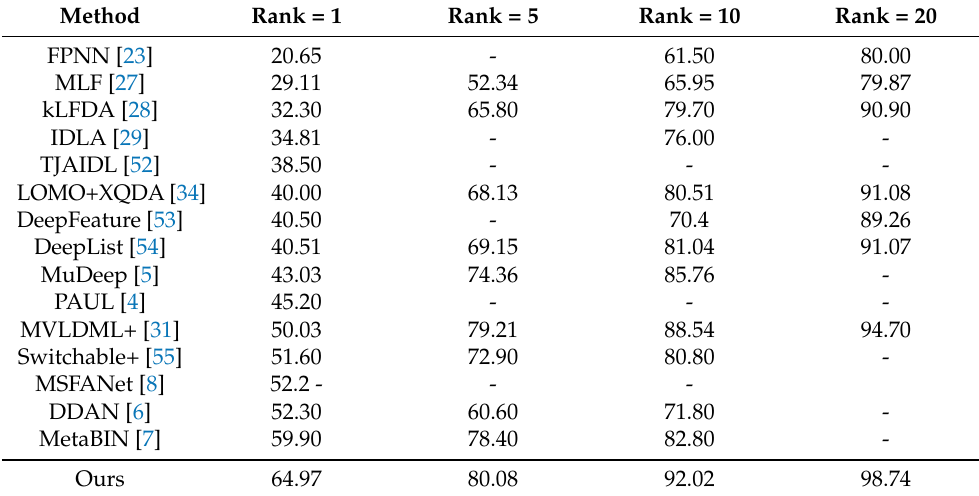
Table 5. Experimental results on VIPeR.